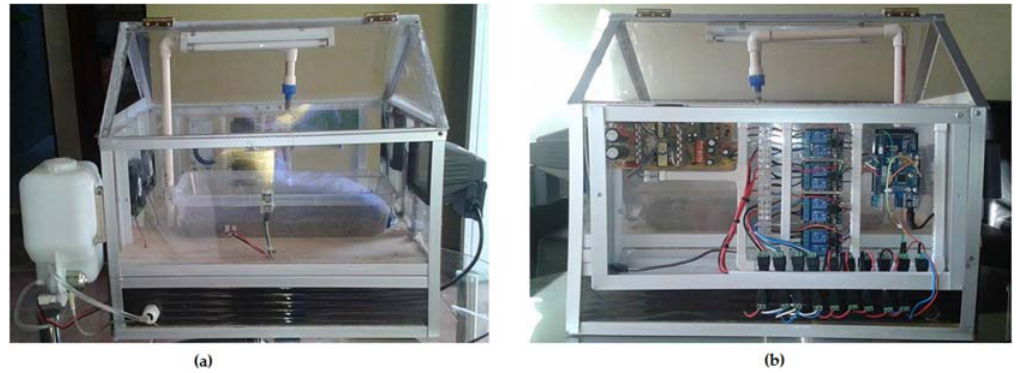
Figure 9. Greenhouse prototype. ( a ) Left side. ( b ) Right side.